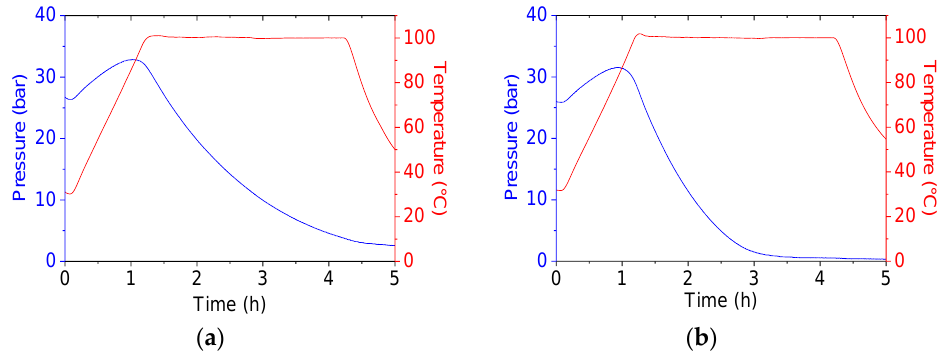
Figure 6. Pressure profile during the glycidol conversion to the corresponding cyclic carbonate for Imi/1Al_SBA-15 ( a ) and Imi/5Al_SBA-15 ( b ). They, respectively, refer to Entries 3 and 4 in Table 2.